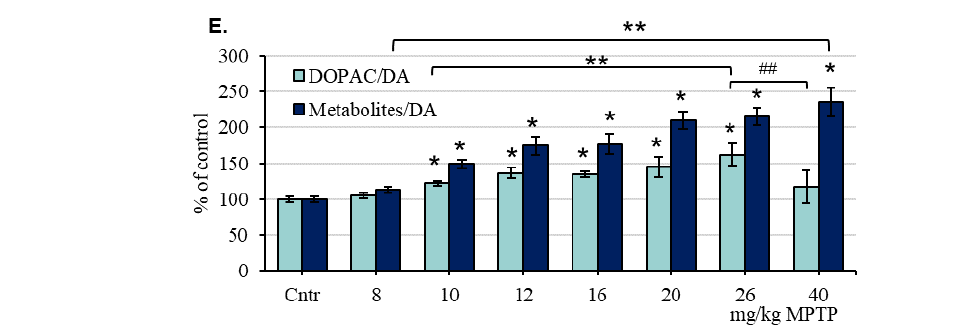
Figure 3. The concentrations of dopamine (DA) ( A ), 3,4-dihydroxyphenylacetic acid (DOPAC) ( B ), homovanillic acid (HVA) ( C ), and 3-methoxytyramine (3-MT) ( D ), as well as dopamine turnover: DOPAC/DA or Metabolites/DA ((DOPAC + HVA + 3-MT)/DA) ( E ), presented as % of the control, in the striatum of mice 24 h after each of the successive injections of 1-methyl-4-phenyl-1,2,3,6- tetrahydropyridine (MPTP) at increasing doses from 8 to 40 mg/kg (“n” per group = 6–8). * p < 0.05, significant differences compared with the control, taken as 100% (the Student’s t -test). ** p < 0.05 significant differences and tendency to change (## p < 0.1) between selected parameters (one-way ANOVA). Data are presented as mean ± SEM. Cntr—the control group received 0.9% NaCl.